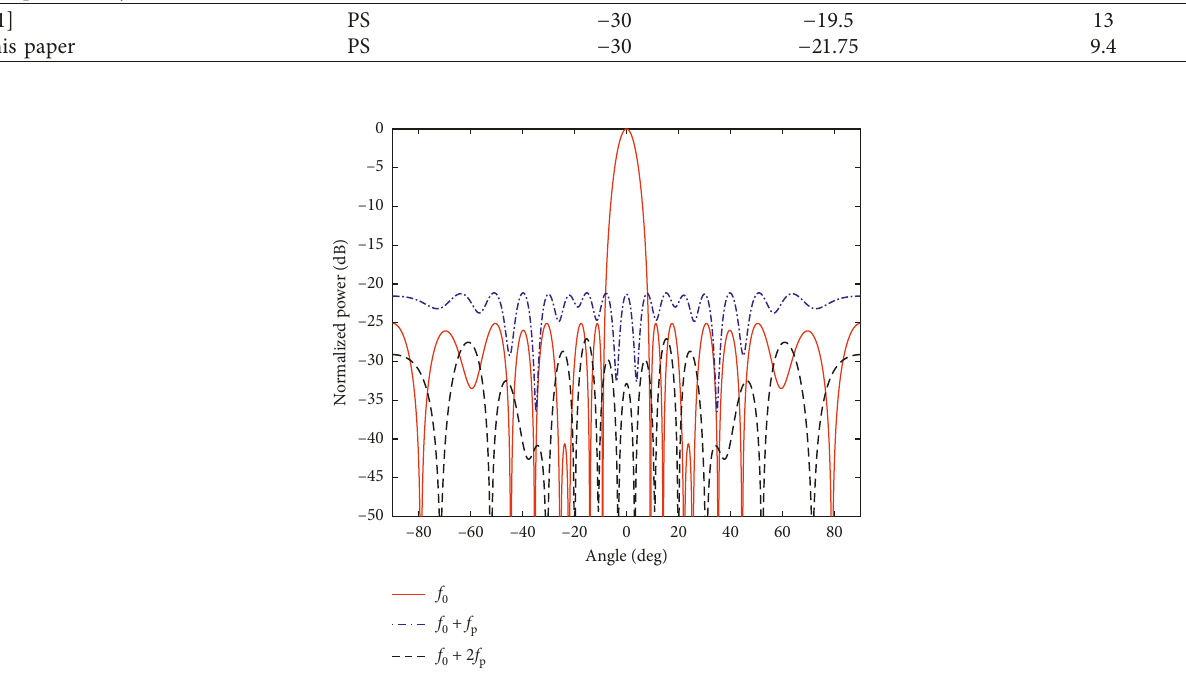
Figure 18: Sideband level comparison of the sparse array and array with a spacing of λ /2. Table 7: Parametric comparison of 16-element between TMSLAs in the PS mode and the results in [21]. Comparison object